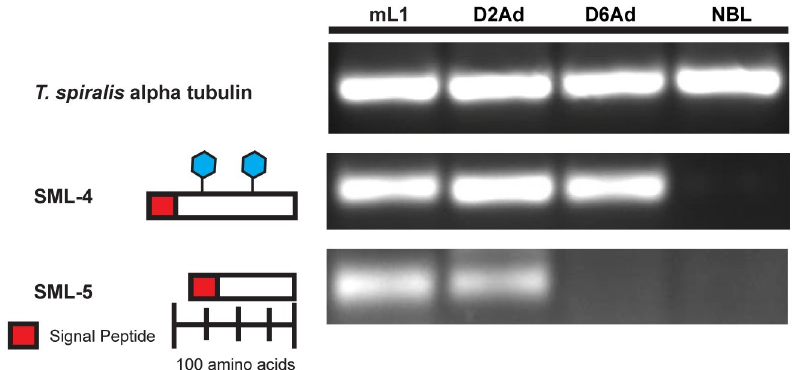
Fig 1. Bioinformatic and expression analysis of two T . spiralis abundant novel transcripts. The cartoon shows features identified in predicted protein translations of two abundant novel transcripts found within the T . spiralis mL1 EST dataset. These include potential signal peptides and confirmed N-linked glycosylation sites. RT-PCR showing the expression of these transcripts at different life cycle stages is also shown, with T . spiralis alpha-tubulin specific primers included to assess the quality of the cDNA used in the expression analysis. mL1: muscle stage larvae, D2Ad: day 2 adults D6Ad: day 6 adults, NBL: newborn larvae.